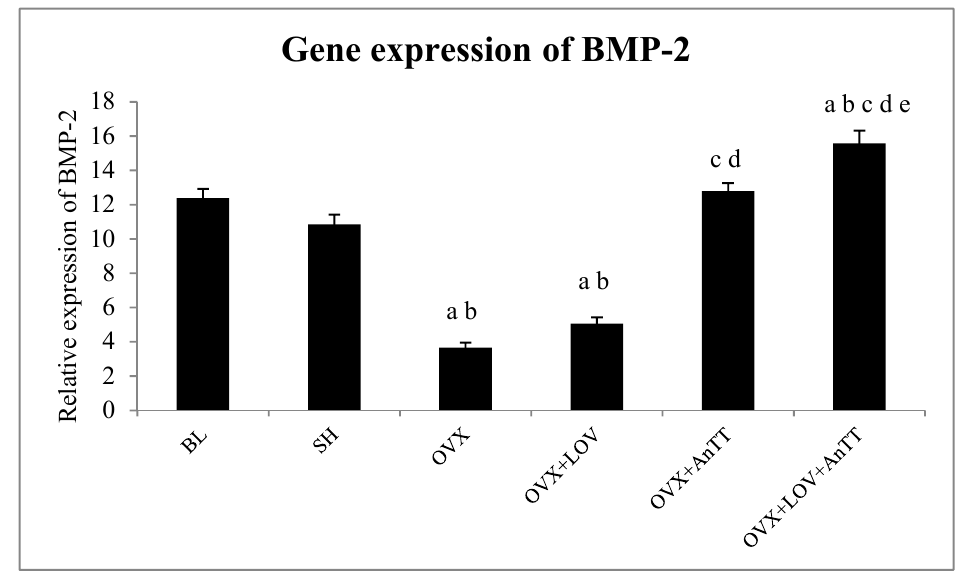
Figure 3. Gene expression of BMP-2 among the study groups. Legend: Letters indicates significant difference between the marked group and ‘a’ BL; ‘b’ SH; ‘c’ OVX+LOV’; ‘d’ OVX+AnTT or ‘e’ OVX+LOV+AnTT. Abbreviation: BL = baseline; SH = sham-operated; OVX = ovariectomized; OVX+LOV = ovariectomized and supplemented with lovastatin (11 mg/day); OVX+AnTT = ovariectomized and supplemented with annatto tocotrienol (60 mg/kg/day); OVX+LOVAnTT = ovariectomized and supplemented with lovastatin (11 mg/day) and annatto tocotrienol (60 mg/kg/day).